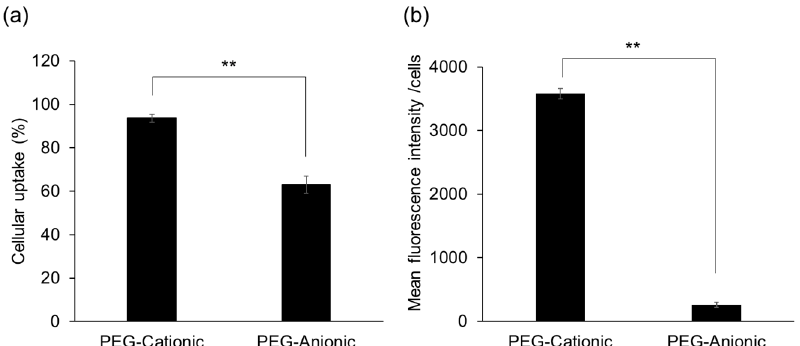
Figure 4. Cellular uptake of PEG liposomes in RAW264.7 murine macrophages. ( a ) Liposomal cellular uptake (%) in treatment compared to control. ( b ) Fluorescent intensity per cell per liposome in RAW264.7 macrophages. Each bar represents the mean ± S.D. (n = 3). ** p > 0.01. Fluorescent-labeled PEG-cationic and PEG-anionic liposomes transfected into RAW264.7 macrophages for 6 h. Samples were measured by flow cytometry.